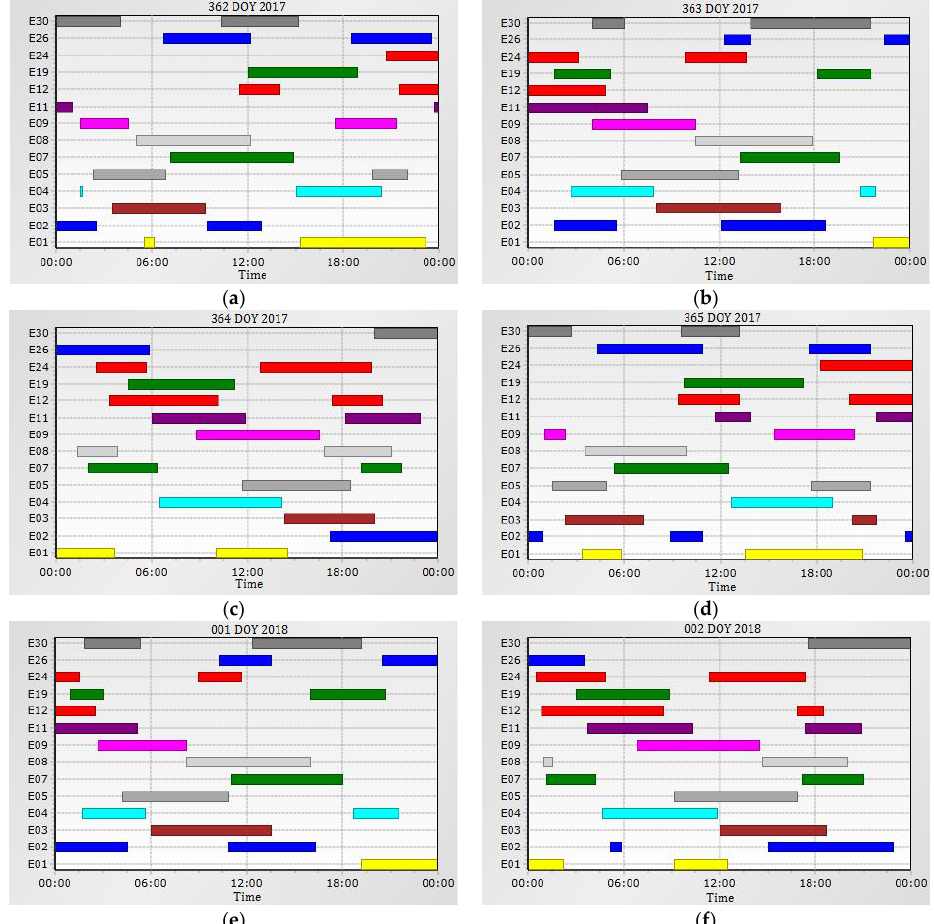
Figure 1. Visibility of the operational satellites of the Galileo constellation at the site Kraków–Poland; ( a ) 362 day of year 2017, ( b ) 363 day of year 2017, ( c ) 364 day of year 2017, ( d ) 365 day of year 2017, ( e ) 1 day of year 2018, ( f ) 2 day of year 2018. Source: Own elaboration based on “GNSS Planning Online”.